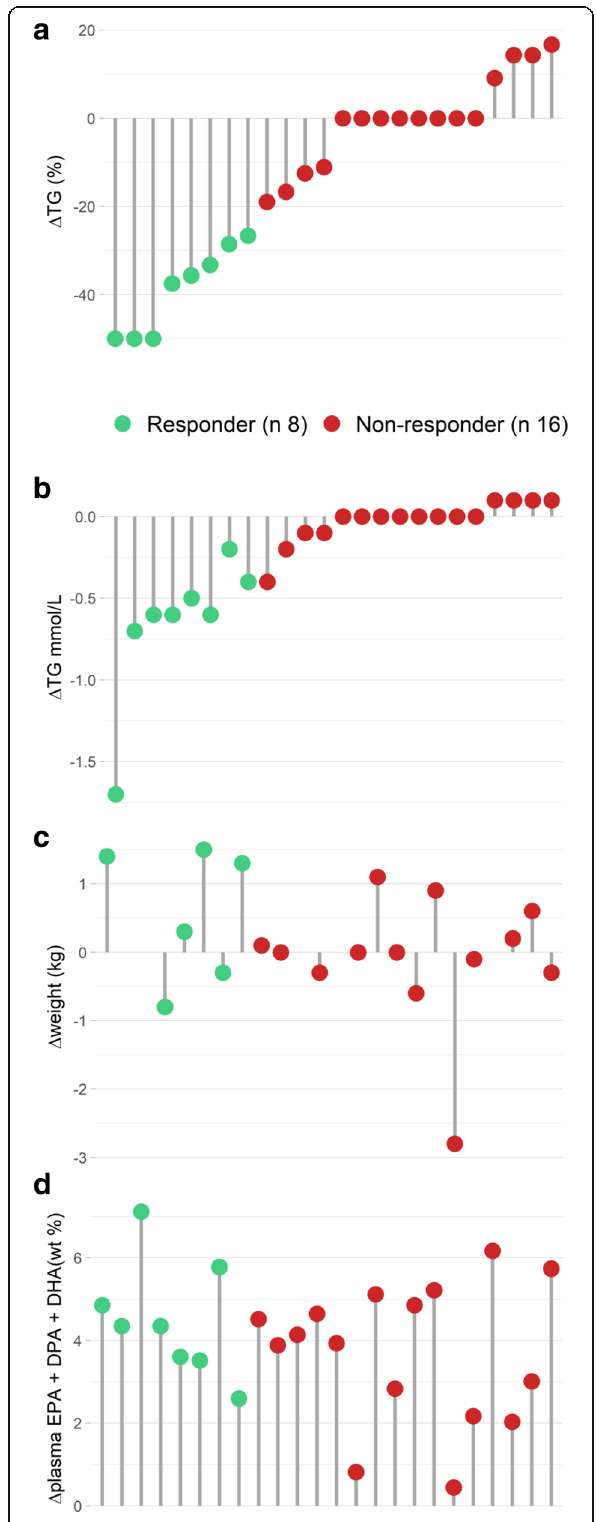
Fig. 1 Individual changes in fasting TG, weight, and plasma levels of omega-3 fatty acids. The relative change in fasting TG levels ( a ) were used to categorize participants as responders ( Δ TG ≤ − 20%, green) and non-responders ( − 20% < Δ TG < + 20%, red). The participants are presented in the same order for the absolute change (mmol/L) in fasting TG levels ( b ), weight change ( c ), and the change in plasma levels of marine omega-3 fatty acids ( d